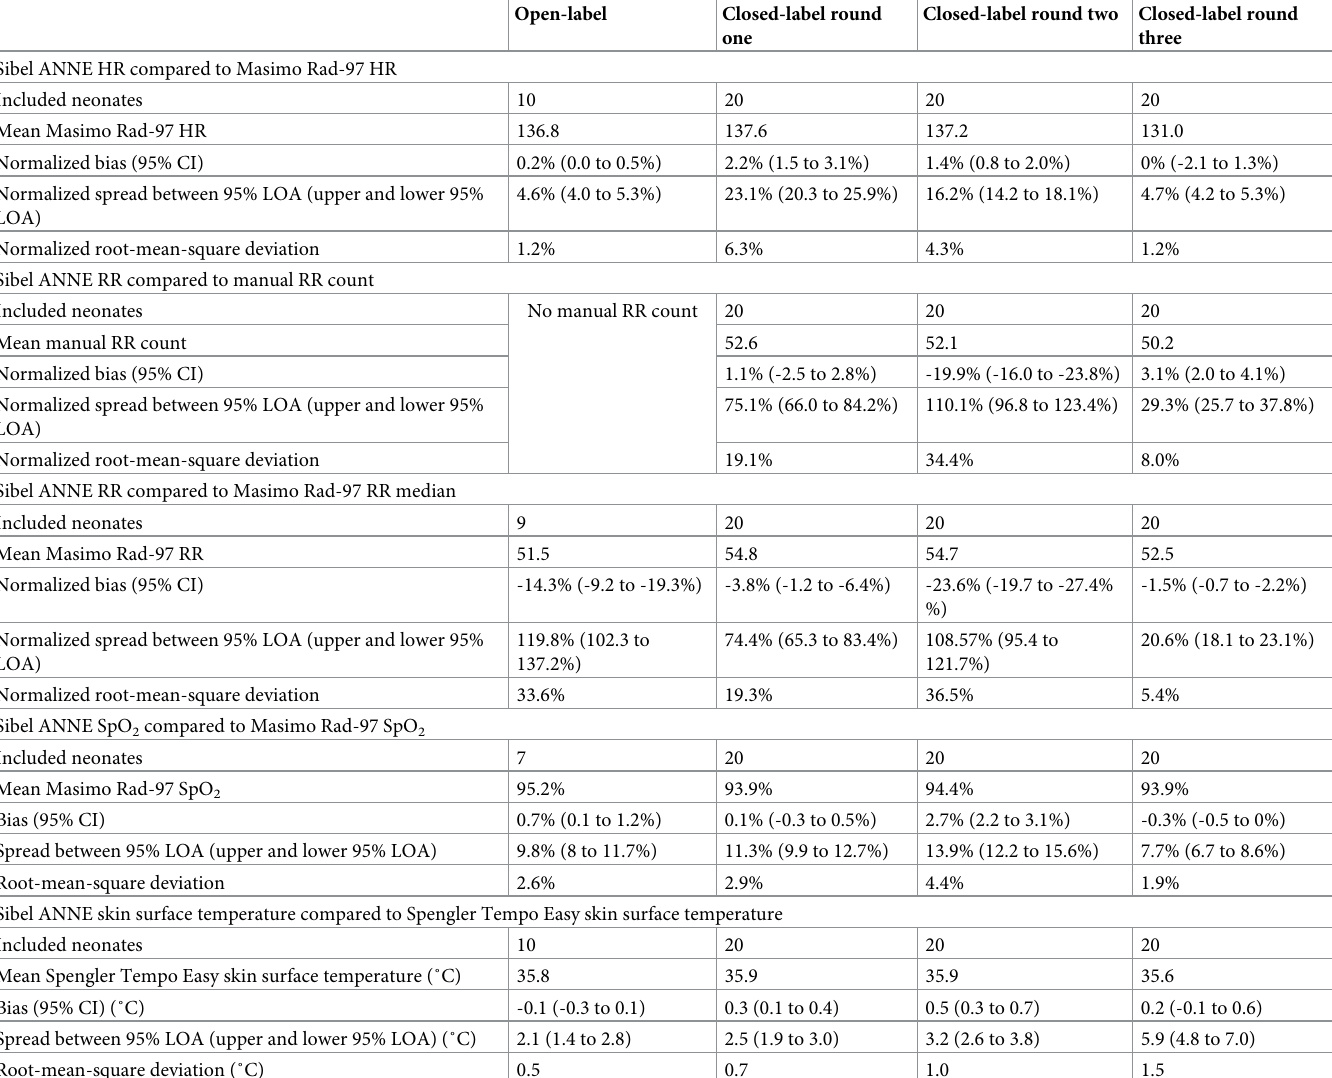
Table 2. Results from Bland-Altman analysis for Sibel ANNE investigational technology versus reference technology.